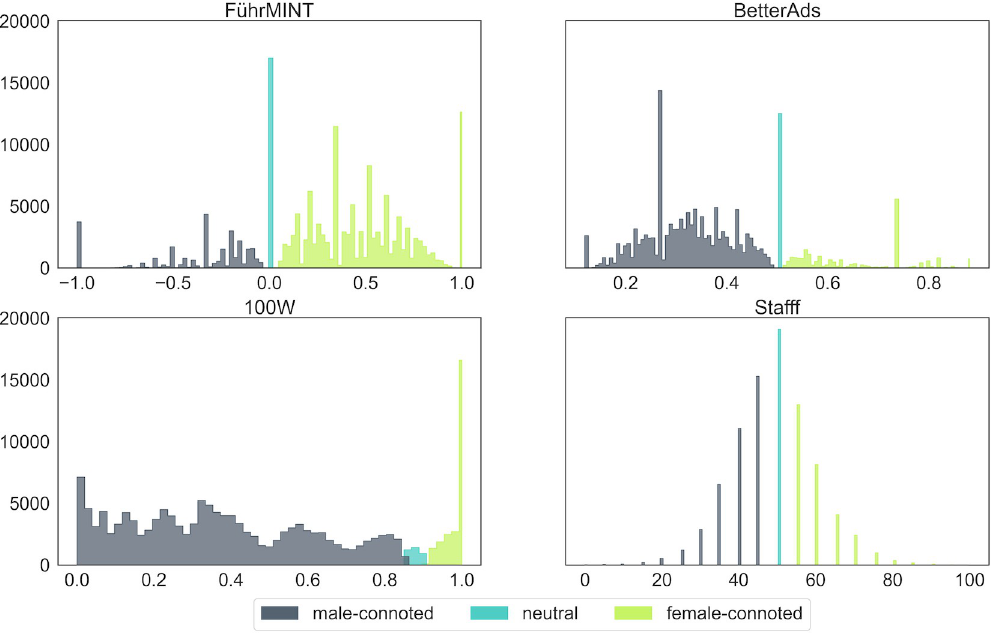
Fig 8. Frequency distribution of gender scores. The colors show the ranges associated with the respective gender